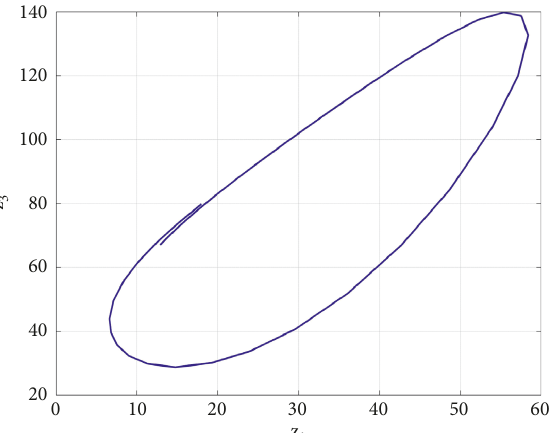
Figure 13: A periodic attractor of the model (1) for b � 20 and ( a, c, d ) � ( 25 , 90 , 6 ) .